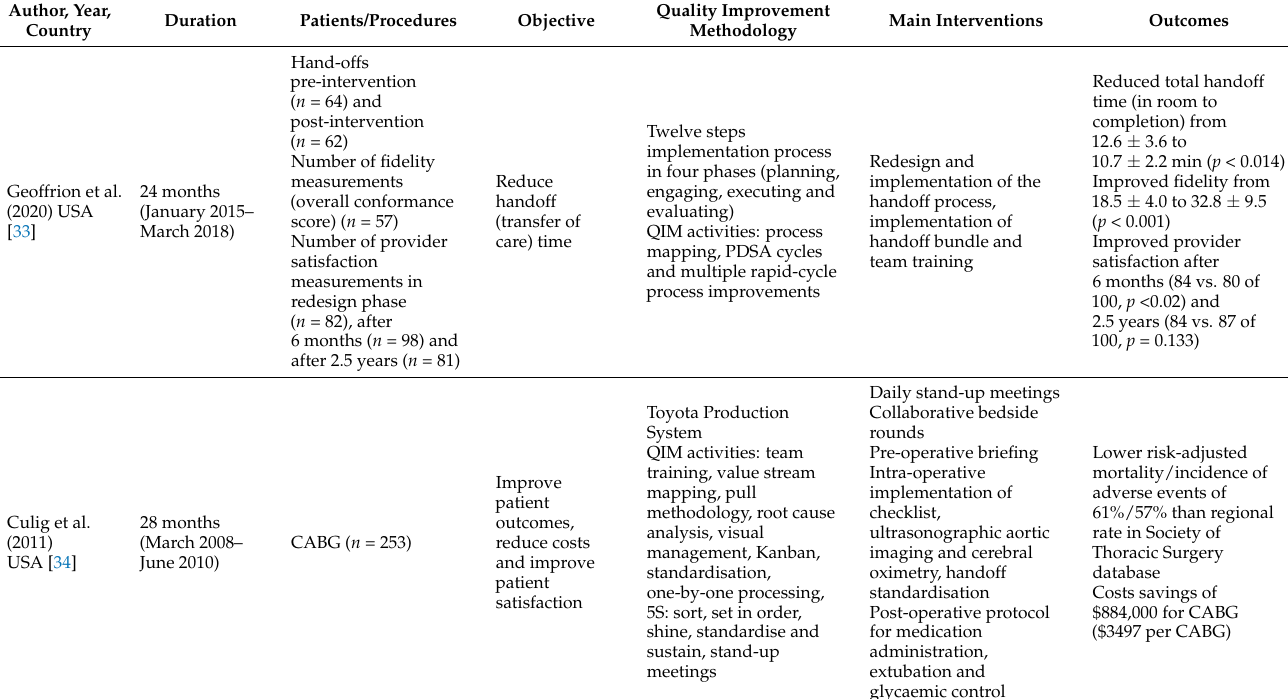
Figure 1. Flowchart of the search and selection procedure of studies. Table 1.